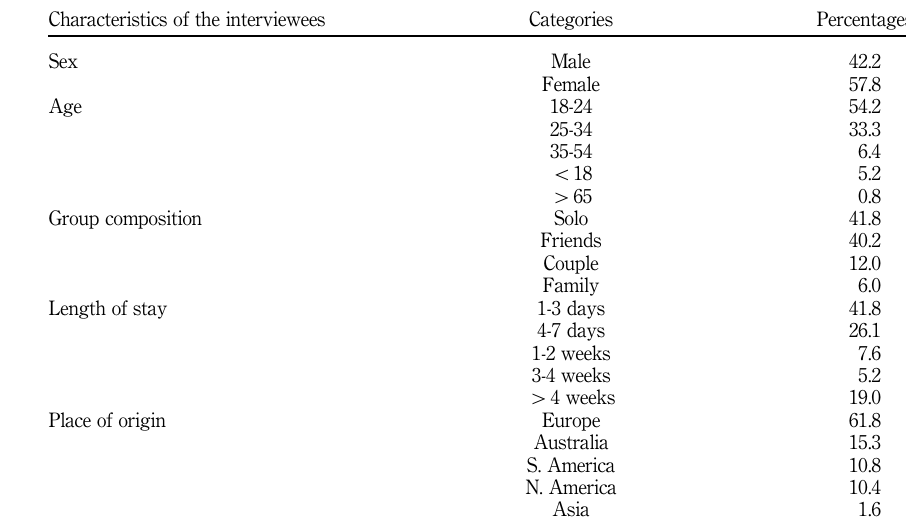
Table II. Profile of the